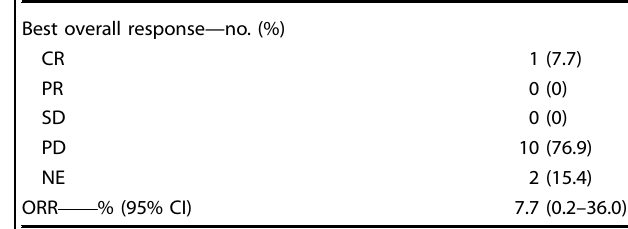
Table 4. Evaluation of response to c4G12